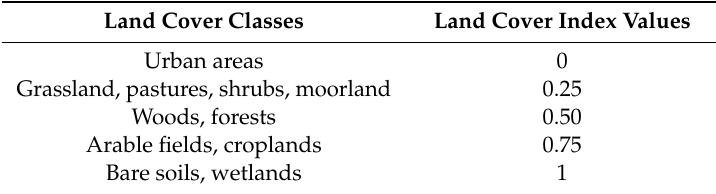
Table 4. Land cover classes and index values associated with sediment mobility (see text for